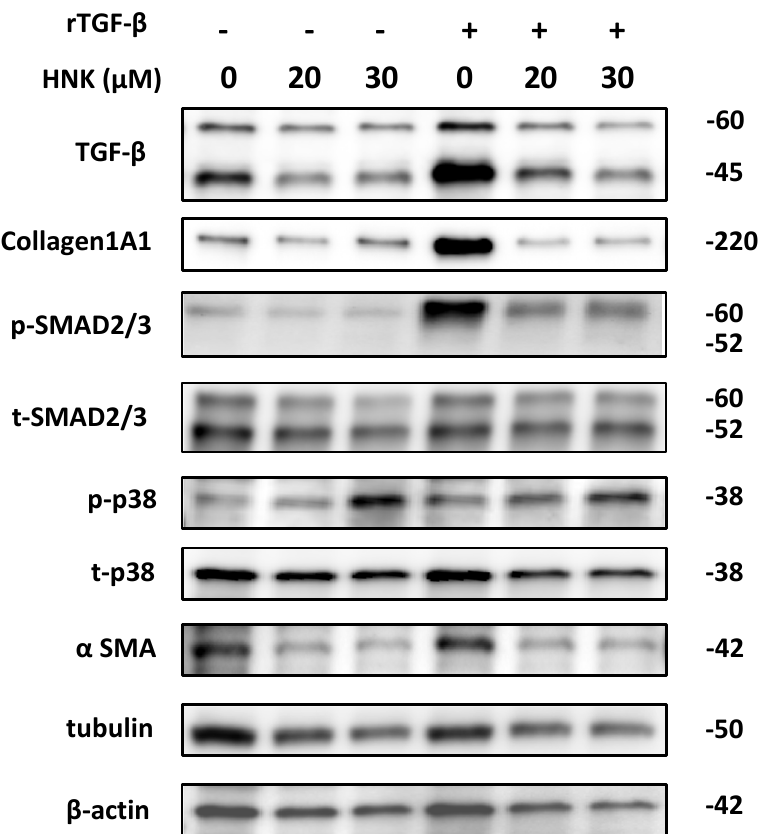
Figure 4. HNK suppresses TGF- β 1 signaling pathways in LX-2 cells. Immunoblot analysis of TGF- β 1 signaling, MAPK signaling, mTOR signaling, and fibrogenesis pathways in LX-2 cells 24 h after incubation in the presence of HNK at the noted concentrations for 24 h, with or without rTGF- β 1 (10 ng/mL) treatment. Tubulin and β -actin were used as loading controls. Numbers on the right indicate the noted molecular weights (kDa). Phosphorylated SMAD2/3 (p-SMAD2/3); total SMAD2/3 (t-SMAD2/3); phosphorylated p38 (p-p38); total p38 (t-p38).